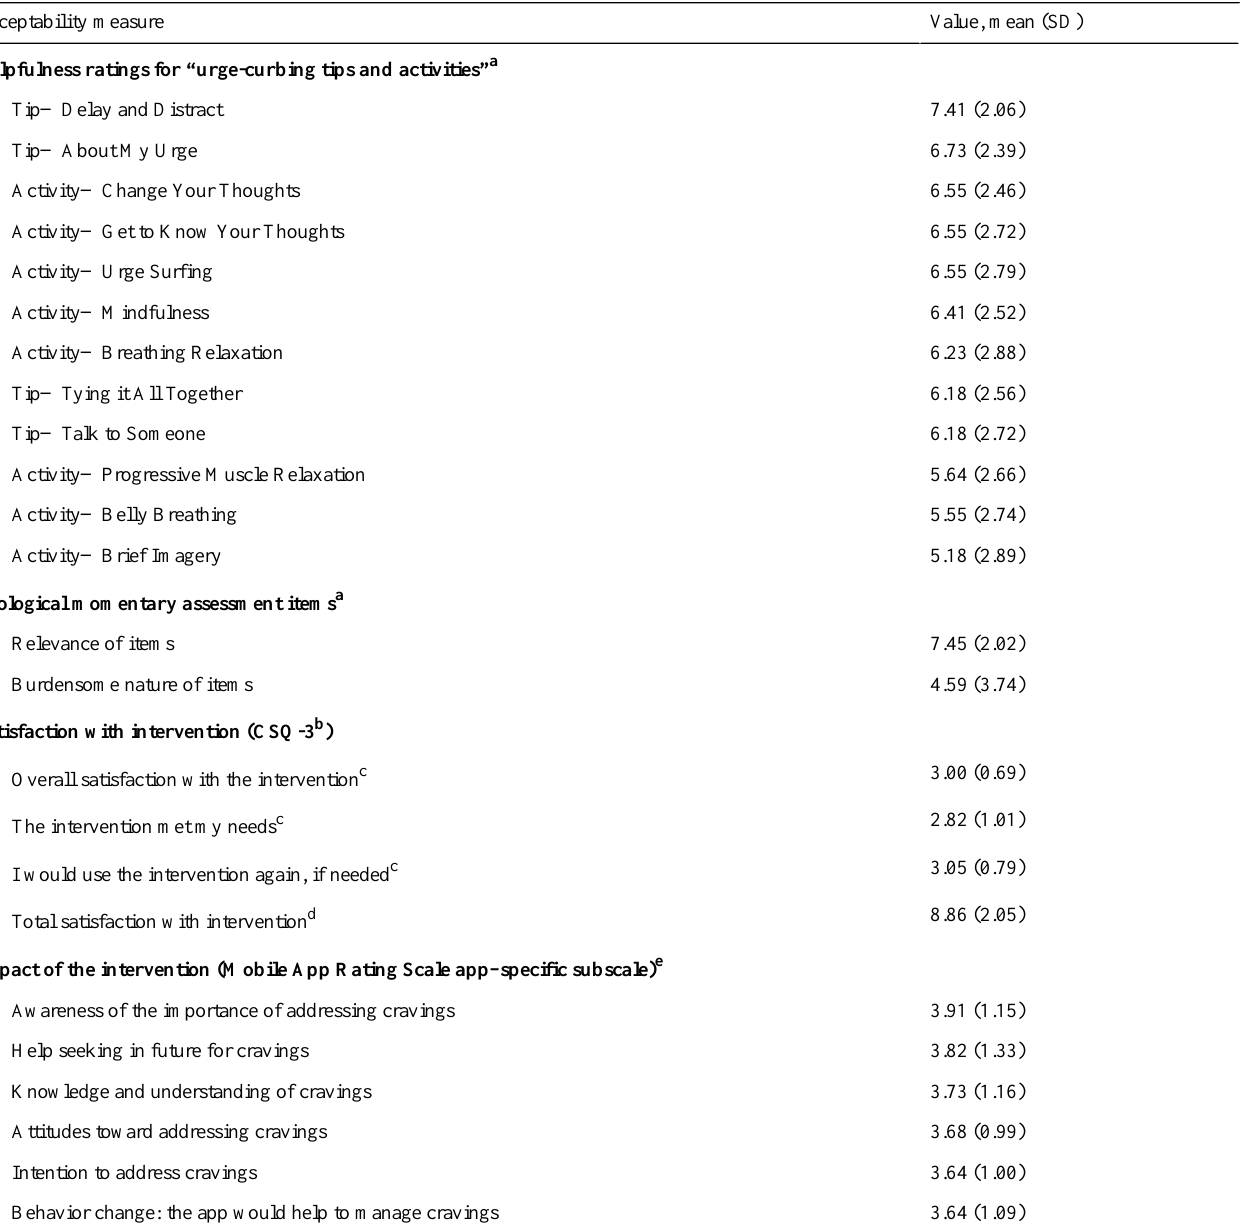
Table 2. Descriptive statistics for postintervention measures